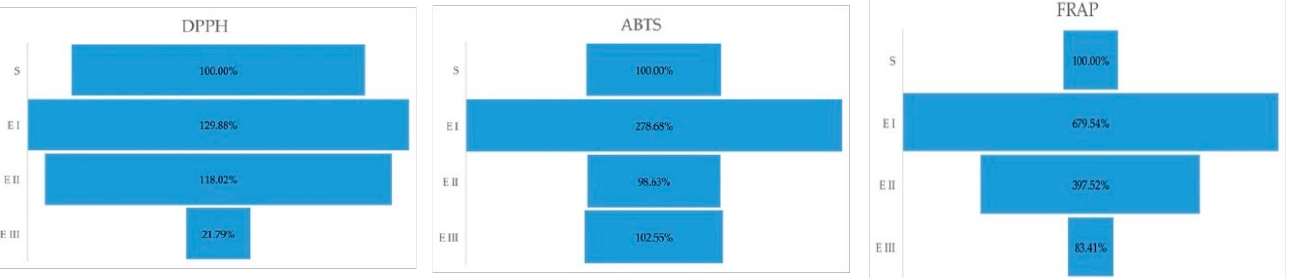
Figure 2. Antioxidant capacity (ABTS, DPPH, FRAP) expressed in percent, during the different